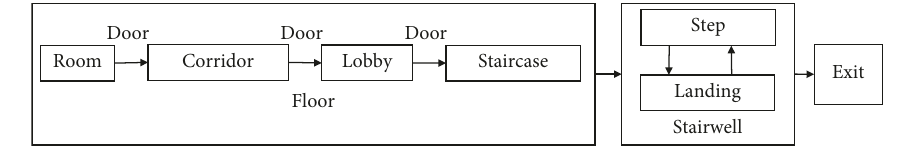
Figure 28: Evacuation sequence based on characteristics of structure.